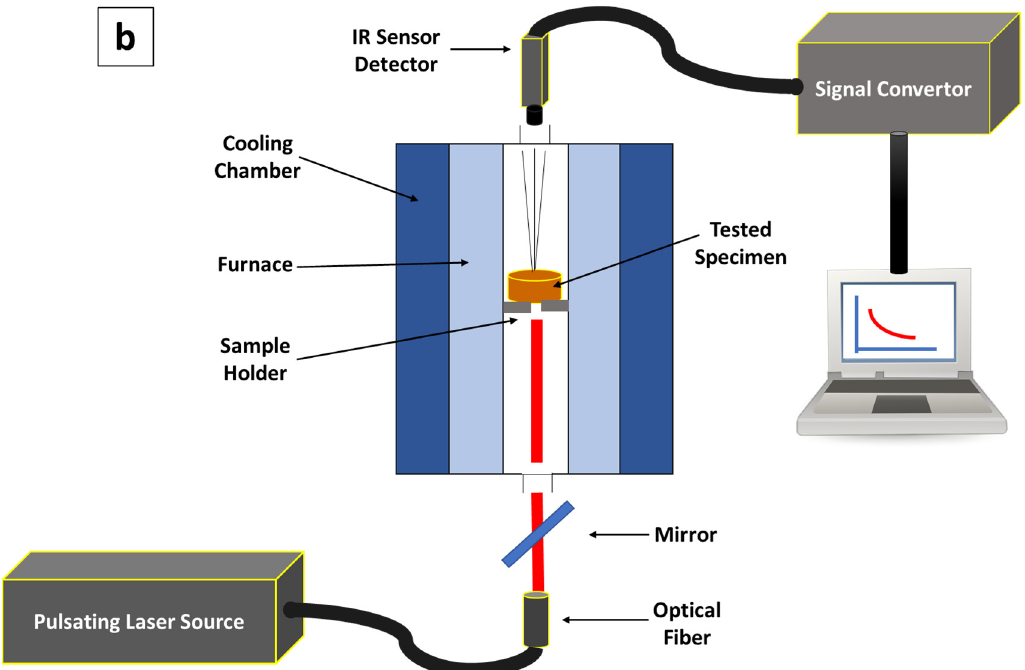
Figure 1. ( a ) Real experimental set-up and ( b ) schematic representation of laser flash technique used for appraising thermal conduction behavior of magnetic / thermoplastic natural rubber (TPNR) nanocomposites.